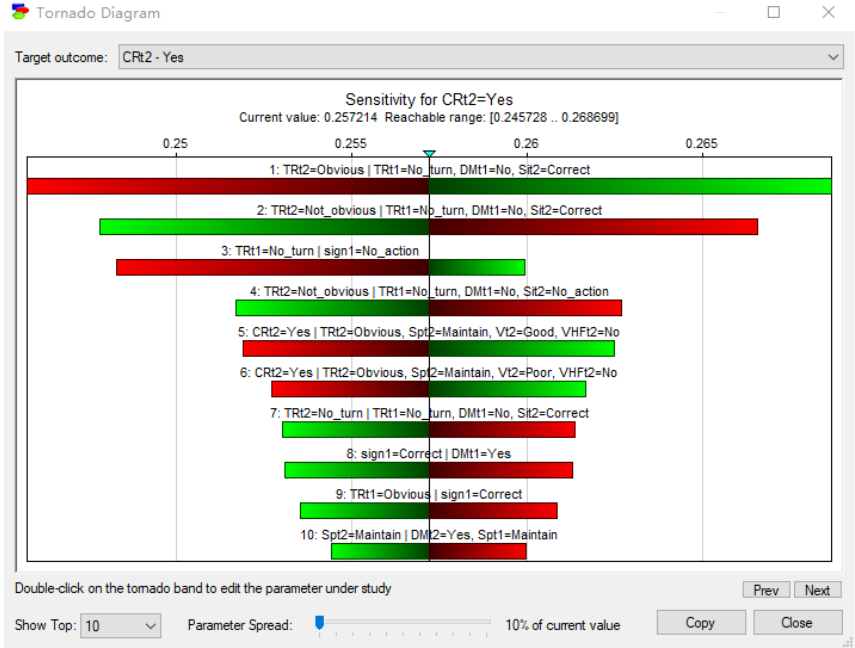
Figure 11. Tornado diagram with “CRt 2 ” as the target variable for sensitivity analysis.